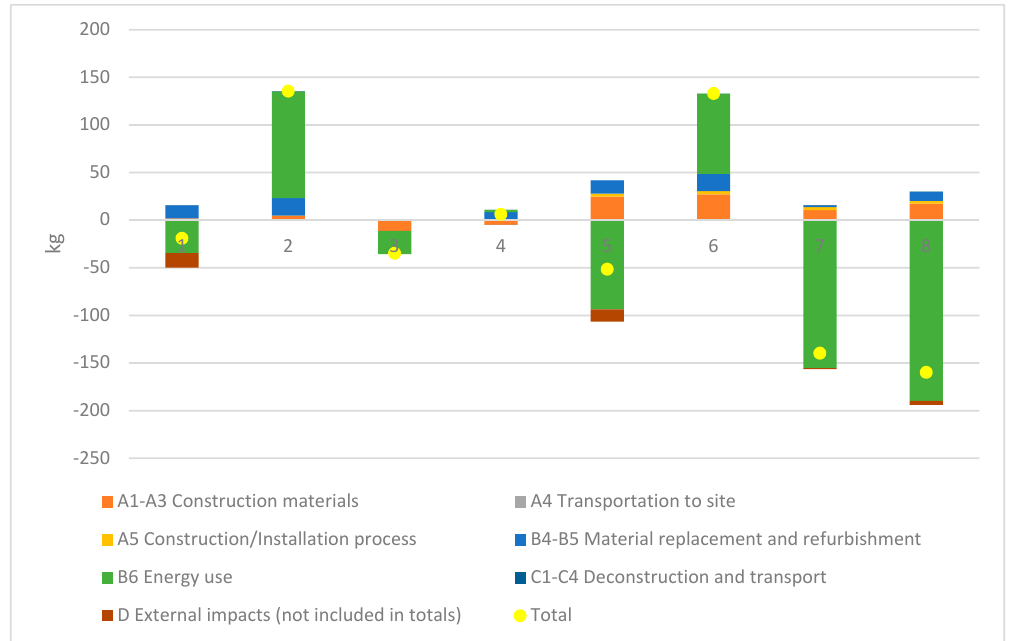
Figure 3. Radioactive waste disposed (kg).